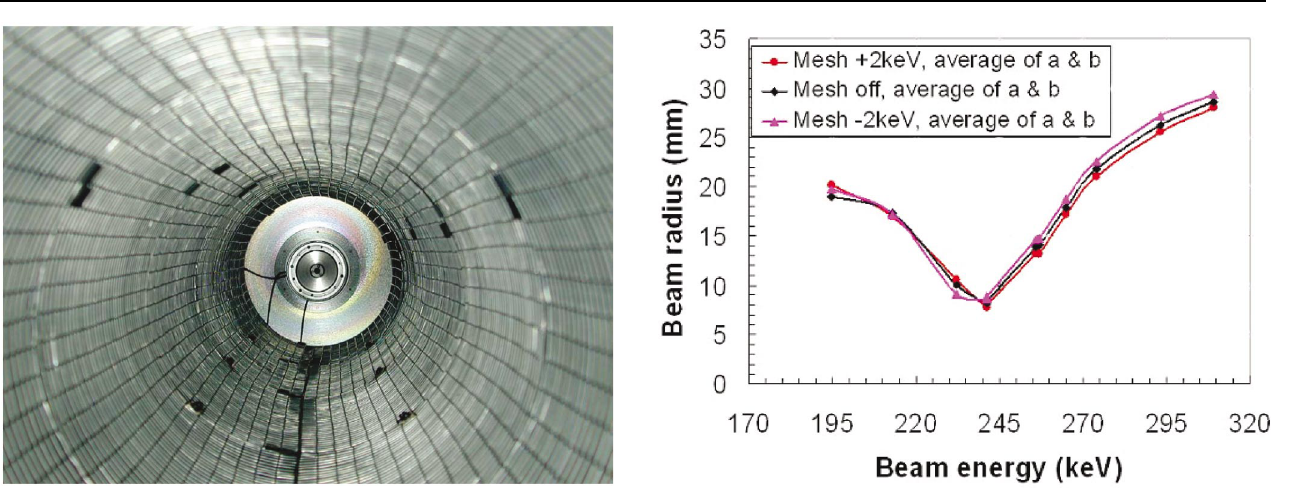
FIG. 20. (Color) Beam radius as a function of beam energy as mesh bias is turned on ( (cid:13) 2 kV ) and